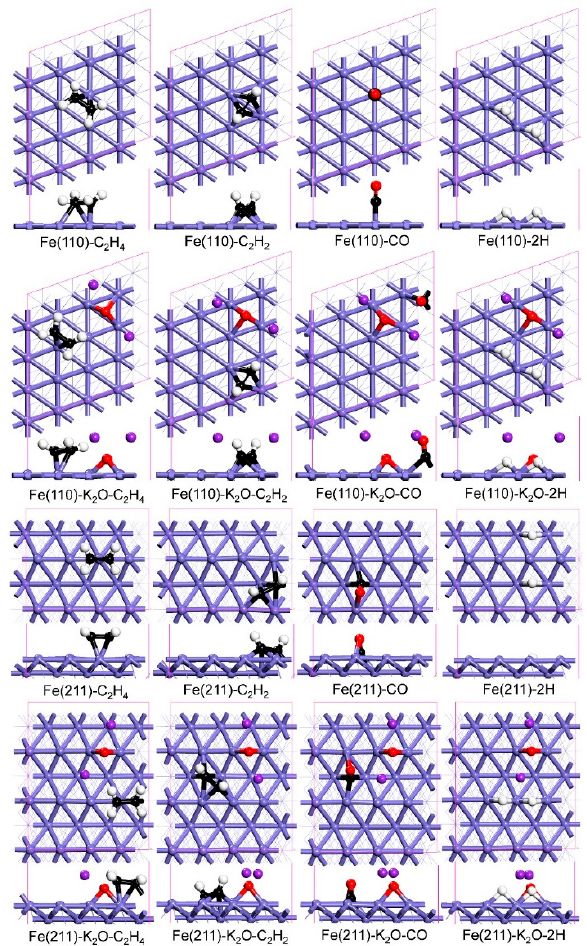
Figure 1. The top and side view configurations of C 2 H 4 , C 2 H 2 , CO and H 2 adsorption on the four surface models. The Fe, K, O, C and H atoms are given in grayish blue, purple, red, black and white,